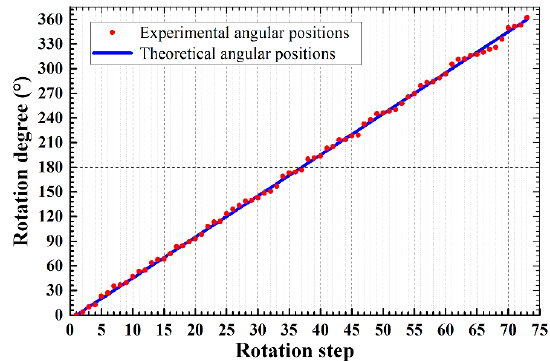
Figure 10. Rotation with 5° angle interval.